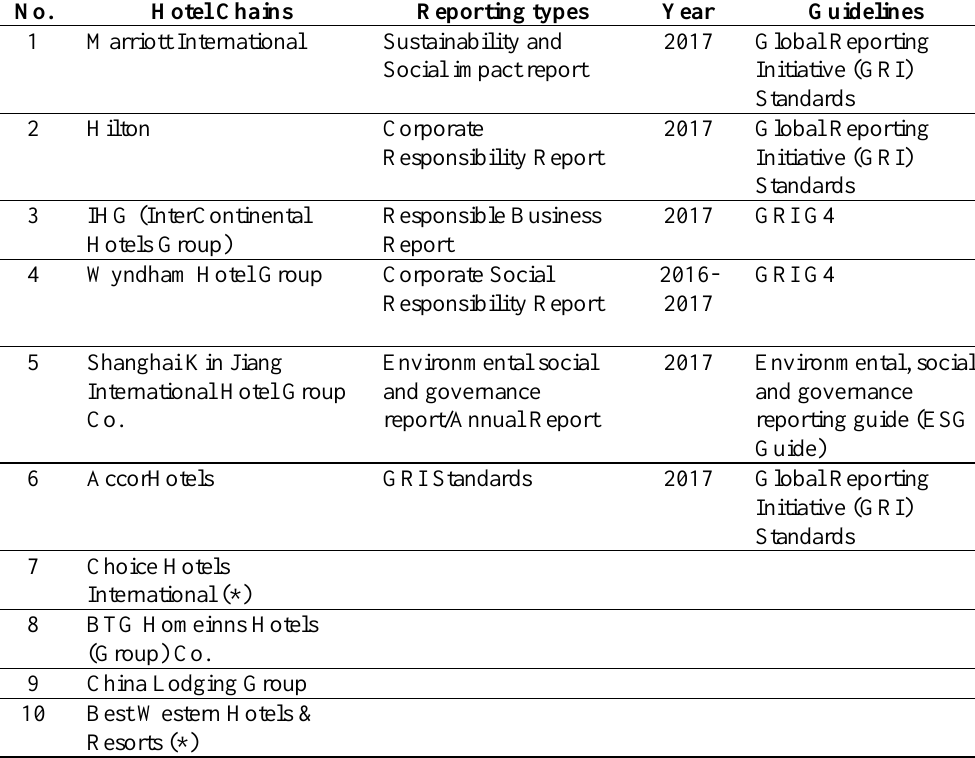
Table 3: Reporting Types No.